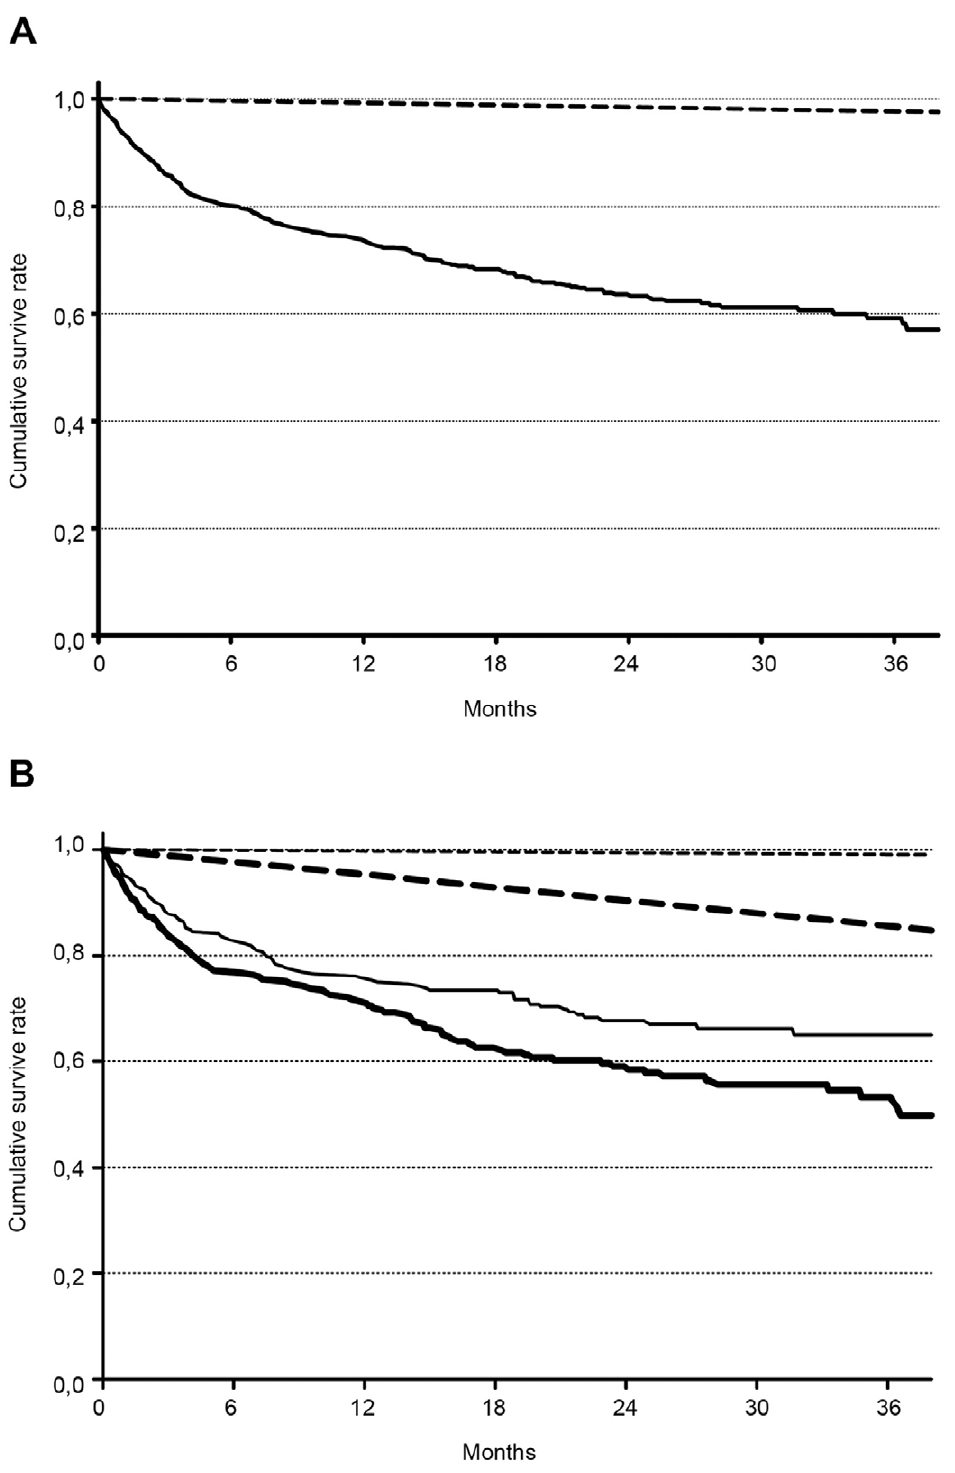
Figure 2. Kaplan-Meier survival curves of (a) the patients discharged alive after an AKI episode (solid line) and of the population of Sa˜o Paulo city (dashed line); (b) Comparison of the effect of age on survival in patients discharged alive after AKI and in the population of Sa˜o Paulo city. Solid lines represent the survival curves of AKI patients, and dashed lines represent the survival of the Sa˜o Paulo population. Regular lines represent patients and population aged , 65 years, and bold lines represent patients and population $ 65 years.